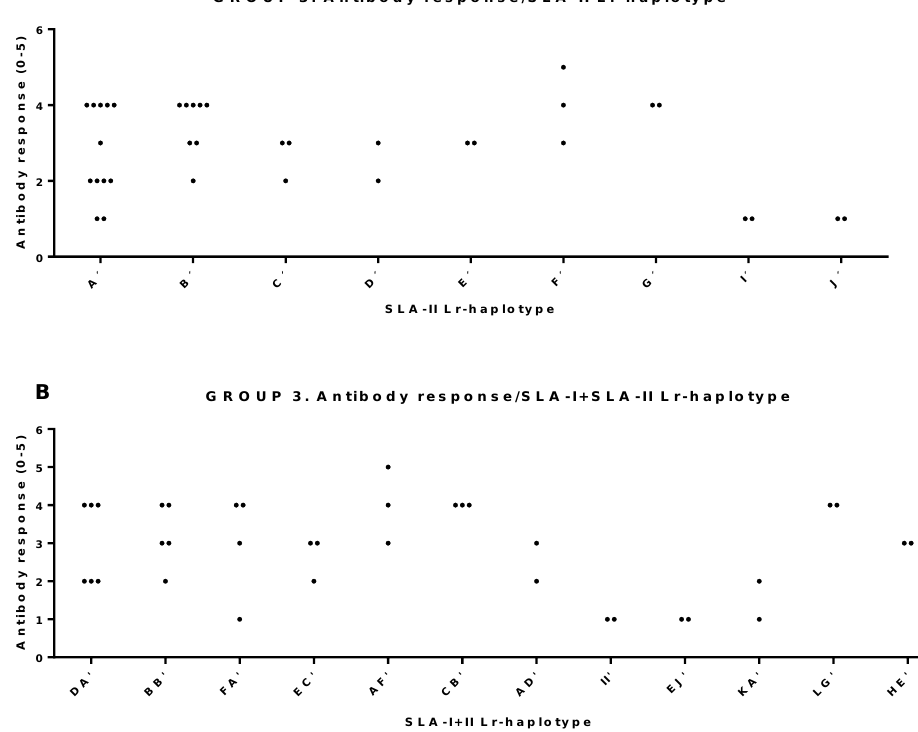
Figure 5. Significant correlations between SLA-II and SLA-I+SLA-II Low-resolution (Lr) haplotypes and antibody response in group 3. Animal group composition as in Table S3, antibody response values as in Table S2 and Figure S1. ( A ) Antibody response and SLA-II haplotype. Significance: χ 2 α = 0.010 *, LR χ 2 α = 0.019 *, Fisher’s exact α = 0.011 *, Cv = 0.65. ( B ) Antibody response and SLA-I + SLA-II haplotype. Significance: χ 2 α = 0.030 *, LR χ 2 α = 0.022 *, Fisher’s exact α = 0.020 *, Cv = 0.72. VNT were categorized as: 0: < 0.0; 1: > 0.9 and < 1.5; 2: > 1.5 and < 1.8; 3: > 1.8 and < 2.4; 4: > 2.4 and < 3; 5: > 3.